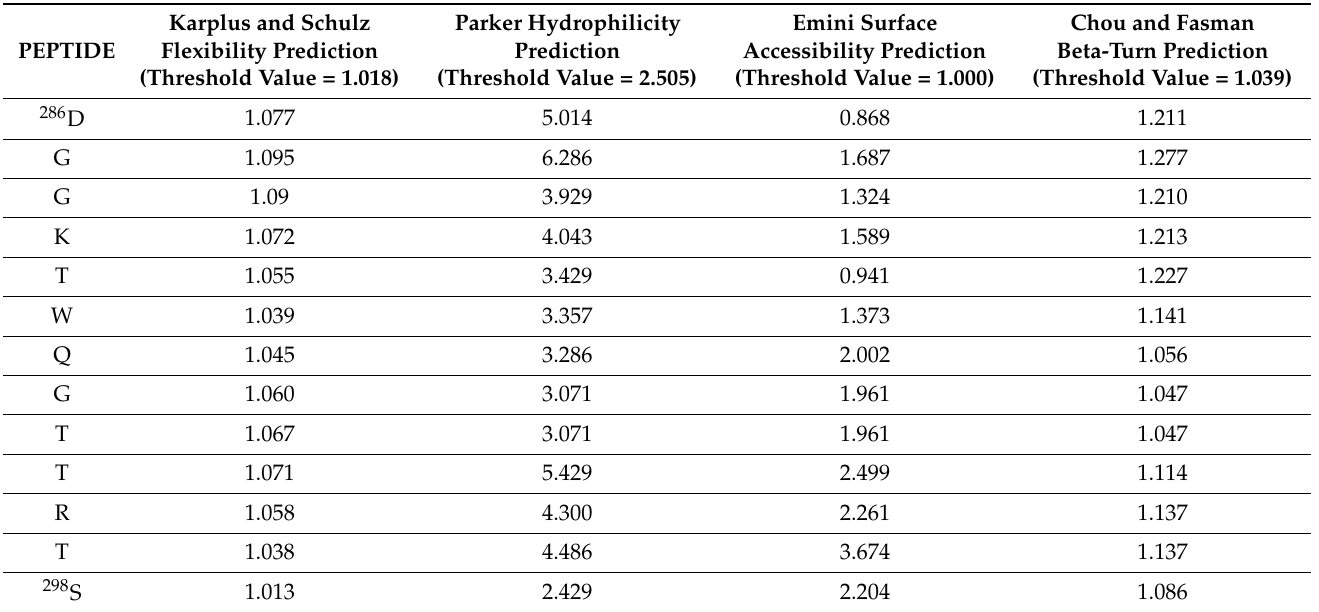
Table 5. Different prediction scores for each amino acid in the second predicted B cell